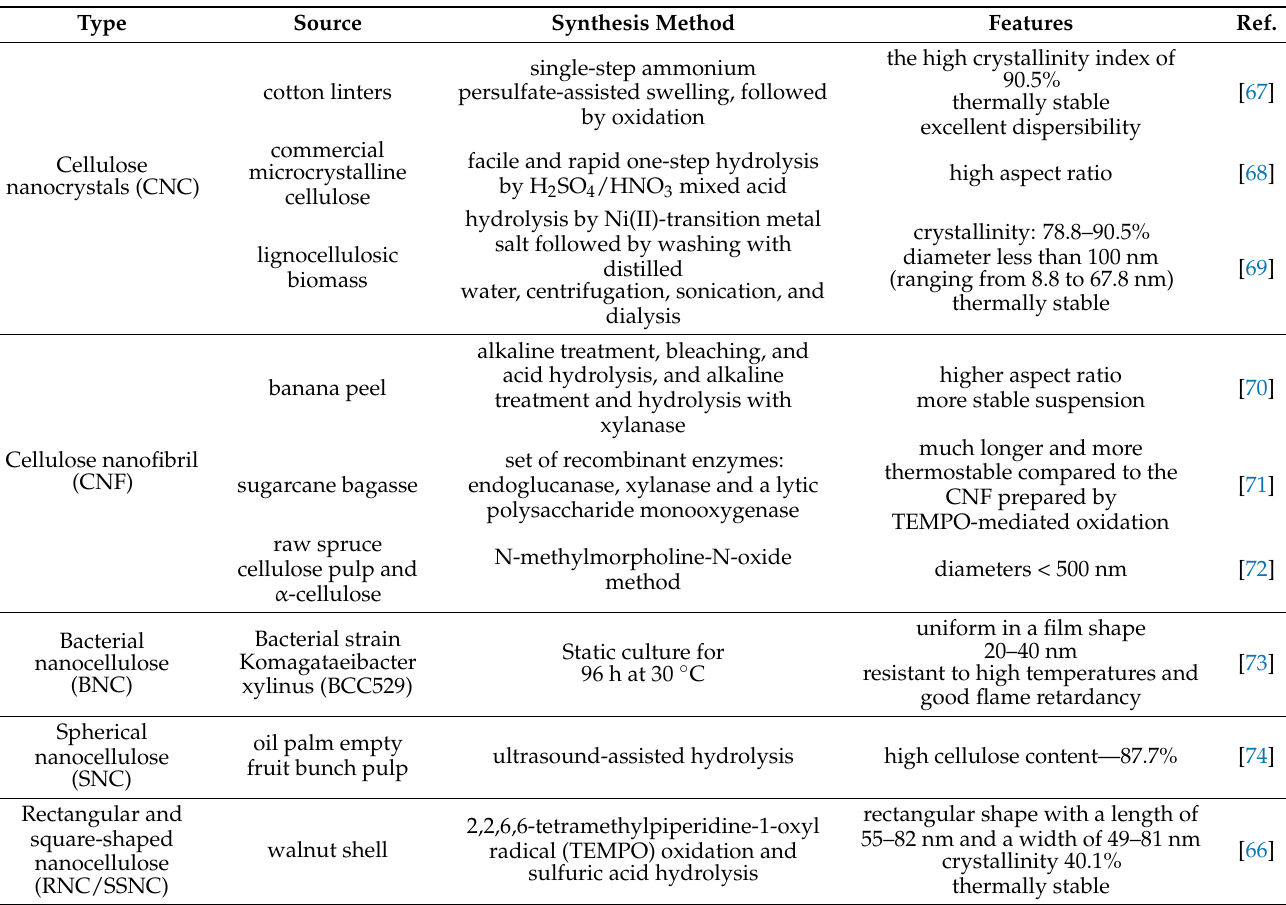
Table 2. Characterization of nanocelluloses in terms of types, source materials, synthesis methods, and critical